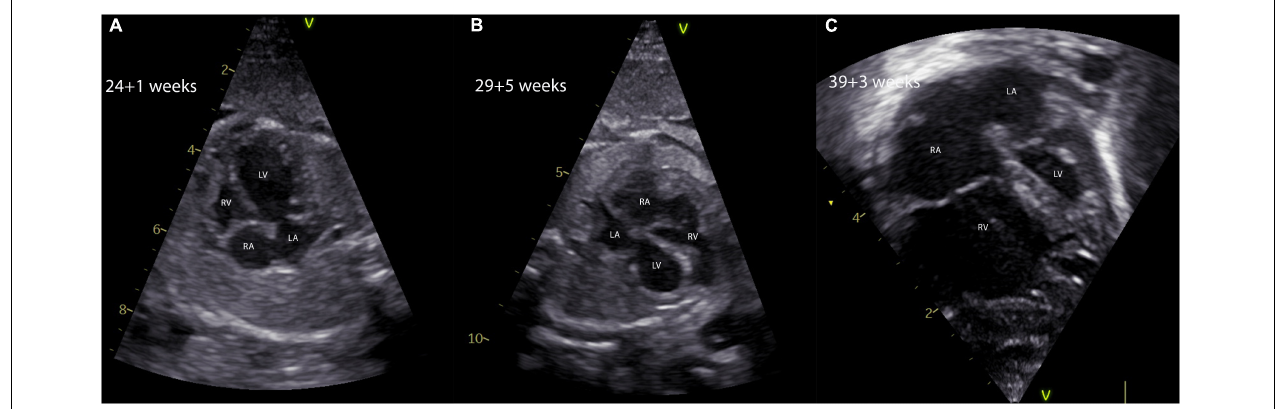
FIGURE 3 | Natural history of a fetus with critical aortic stenosis. The evolution of a hypoplastic left heart syndrome in a fetus with critical aortic stenosis is shown. The fetus was diagnosed at 24 + 1 weeks of gestation with a severely dilated and poorly contracting, but apex forming left ventricle (A) . Five weeks later the fetus showed marked signs of left ventricular hypoplasia and severe EFE, the apex being formed by the right ventricle (B) . In panel (C) , the four-chamber view of the same fetus shows severe left ventricular hypoplasia in terms of a hypoplastic left heart syndrome making a univentricular palliation inevitable. EFE, endocardial fibroelastosis; LA, left atrium; LV, left ventricle; RA, right atrium; RV, right ventricle.